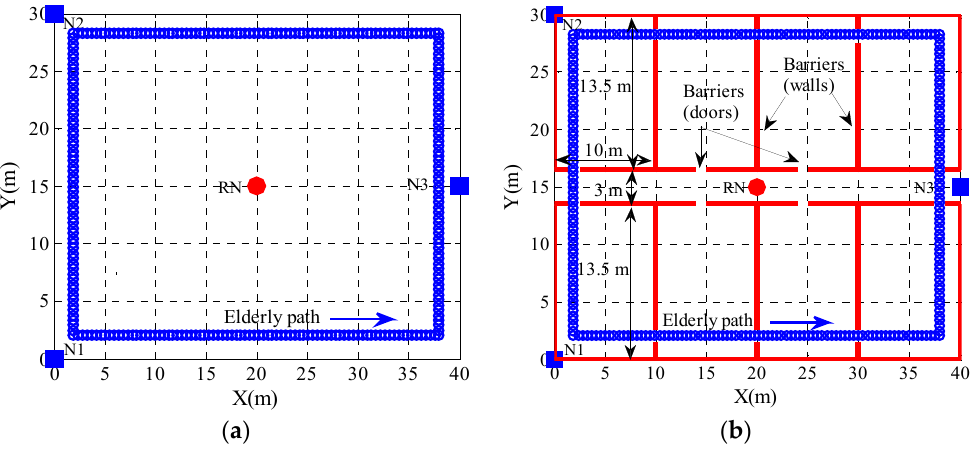
Figure 4. Adopted indoor environments ( a ) LOS and ( b ) NLOS.